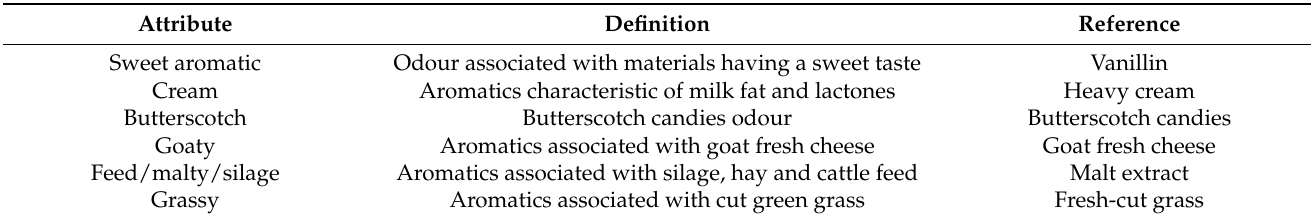
Table 2. Definitions and reference standards of odour attributes used in the sensory analysis of raw goat milk